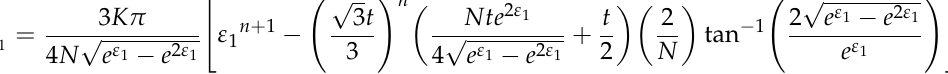
It can be observed that the wrinkle length s and the tube wall thickness t are the same dimensions, so there are multiple relationships between the defined wrinkle length and the tube wall thickness: Combined with the above formula, the critical internal pressure P cr 1 of the tube without wrinkling can be expressed as: